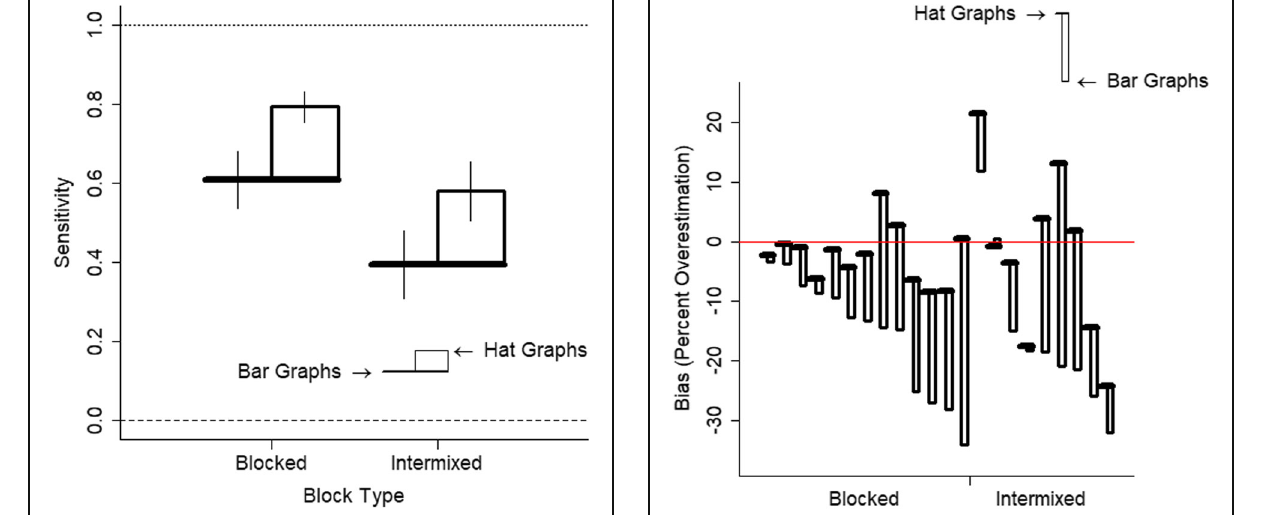
Fig. 14 Sensitivity is potted as a function of block type and graph type. Sensitivity is measured as the slope. Higher scores indicate better sensitivity. Scores of 1 indicate perfect sensitivity and scores of 0 indicate no sensitivity. The brims correspond to the bar graph condition whereas the crowns correspond to the hat graph condition. Error bars are ±1 SEM calculated from the linear mixed models